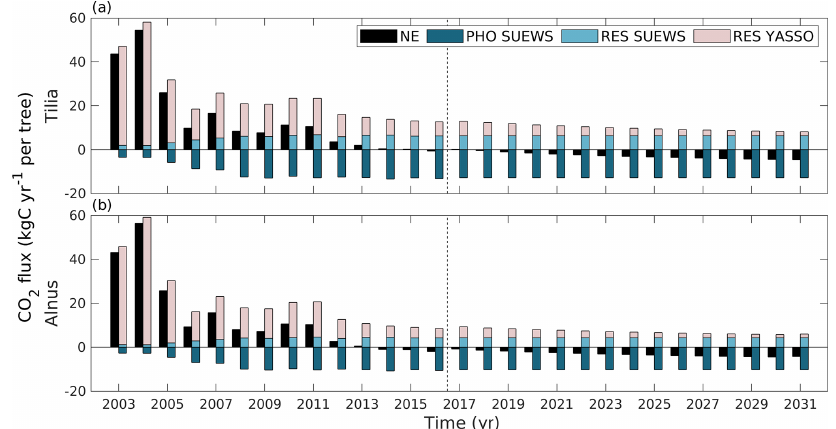
Figure 9. Estimated annual net exchange (NE, black) of street tree plantings, CO 2 uptake by photosynthesis (PHO SUEWS, dark blue), emissions from tree respiration (RES SUEWS, light blue) simulated with SUEWS, and emissions from soil respiration simulated with Yasso (RES Yasso, light rose) at the Tilia (a) and Alnus (b) sites. The dashed line separates the actual simulations from the estimations made with mean meteorological forcing. Here, positive values indicate a release of CO 2 to the atmosphere and negative values indicate uptake from the